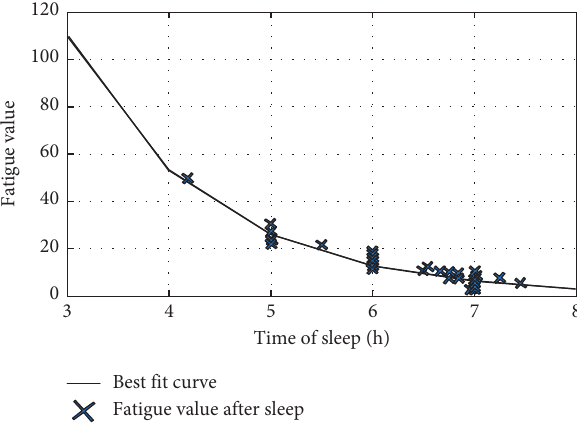
Figure 8: Fatigue value changes caused by time of sleep.